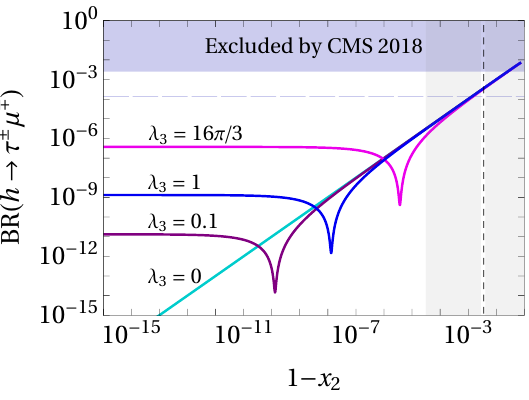
Figure 5 . BR ( h → τ ± µ ∓ ) versus 1 − x 2 for various values of the triple-scalar coupling λ 3 ; all the other input parameters are as in BP-1. The bands shadowed in light gray are excluded by inequalities (2.44). The vertical dashed line marks the value 1 − x